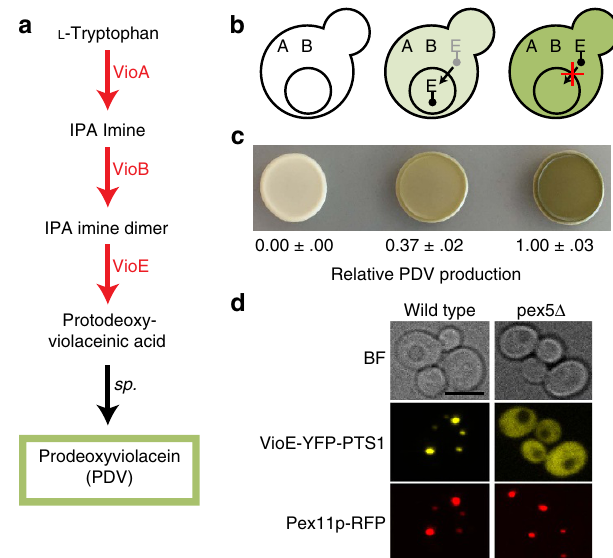
Figure 1 | An enzyme-linked assay for peroxisomal import efficiency reveals cytosolic activity of PTS1-targeted cargo. ( a ) The green pigment PDV is produced from L -tryptophan as the result of three enzymatic steps (red arrows) and one spontaneous reaction (black arrow). ( b ) The precursors of PDVare colourless, so VioA and VioB can be freely expressed in the cytosol of yeast without any colour change (left). Efficient PTS1 targeting of VioE will result in enzyme sequestration in the peroxisome and considerably reduced PDV production in a wild-type strain (middle) compared with a pex5 D strain that is deficient for PTS1 import (right). ( c ) Agar plate spots corresponding to the strains depicted above after 36h of growth. VioE included a C-terminal YFP fusion and the canonical PTS1 tag (SKL). HPLC quantification of relative PDV production is included below each spot. ( d ) Fluorescence microscopy of yeast cells coexpressing the peroxisomal marker Pex11p-RFP and the VioE-YFP-PTS1 fusion protein in either a wild-type or pex5 D strain background. Scale bar, 10 m